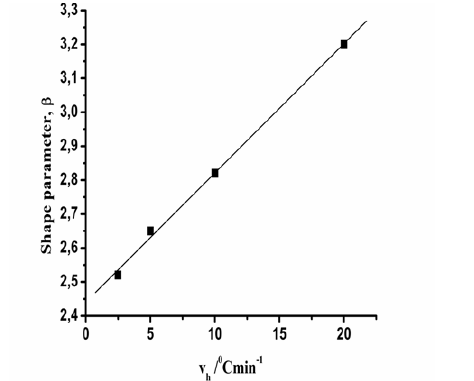
Figure 4 – The linear functional relationship between the Weibull shape parameter ( β ) and the heating rate (v h ) (Eq. (12)) for the reduction process of NiO under hydrogen atmosphere Slika 4 – Linearna funkcionalna veza izme đ u Vejbulovog parametra oblika ( β ) i brzine